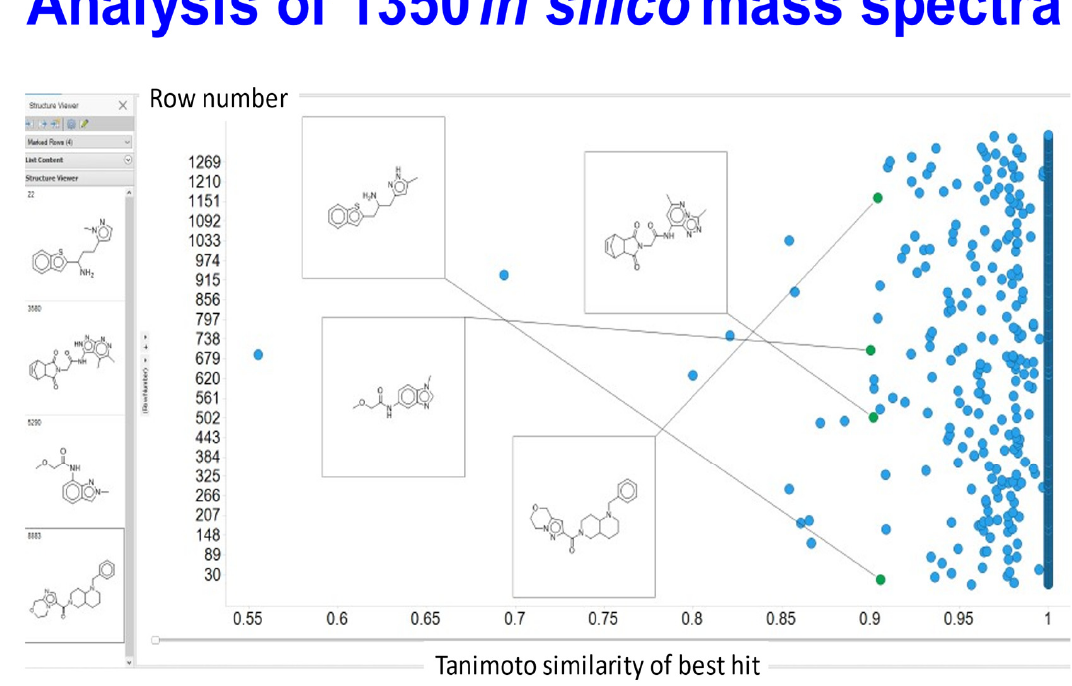
Figure 3. Analysis of a test set of predictions of the molecules behind 1350 in silico-fragmented mass spectral peaks. The peak lists were passed through the transformer after it had been trained and fine-tuned as described in methods. The analysis was done single-blind and the results fed back. The ‘closeness’ between the molecule estimated and the true molecule is given as the highest Tanimoto similarity based on six encodings. Four estimated molecules with a TS of ~0.9 are illustrated, together (at left) with the ‘true’ molecules. It is again obvious that they are extremely close structurally.